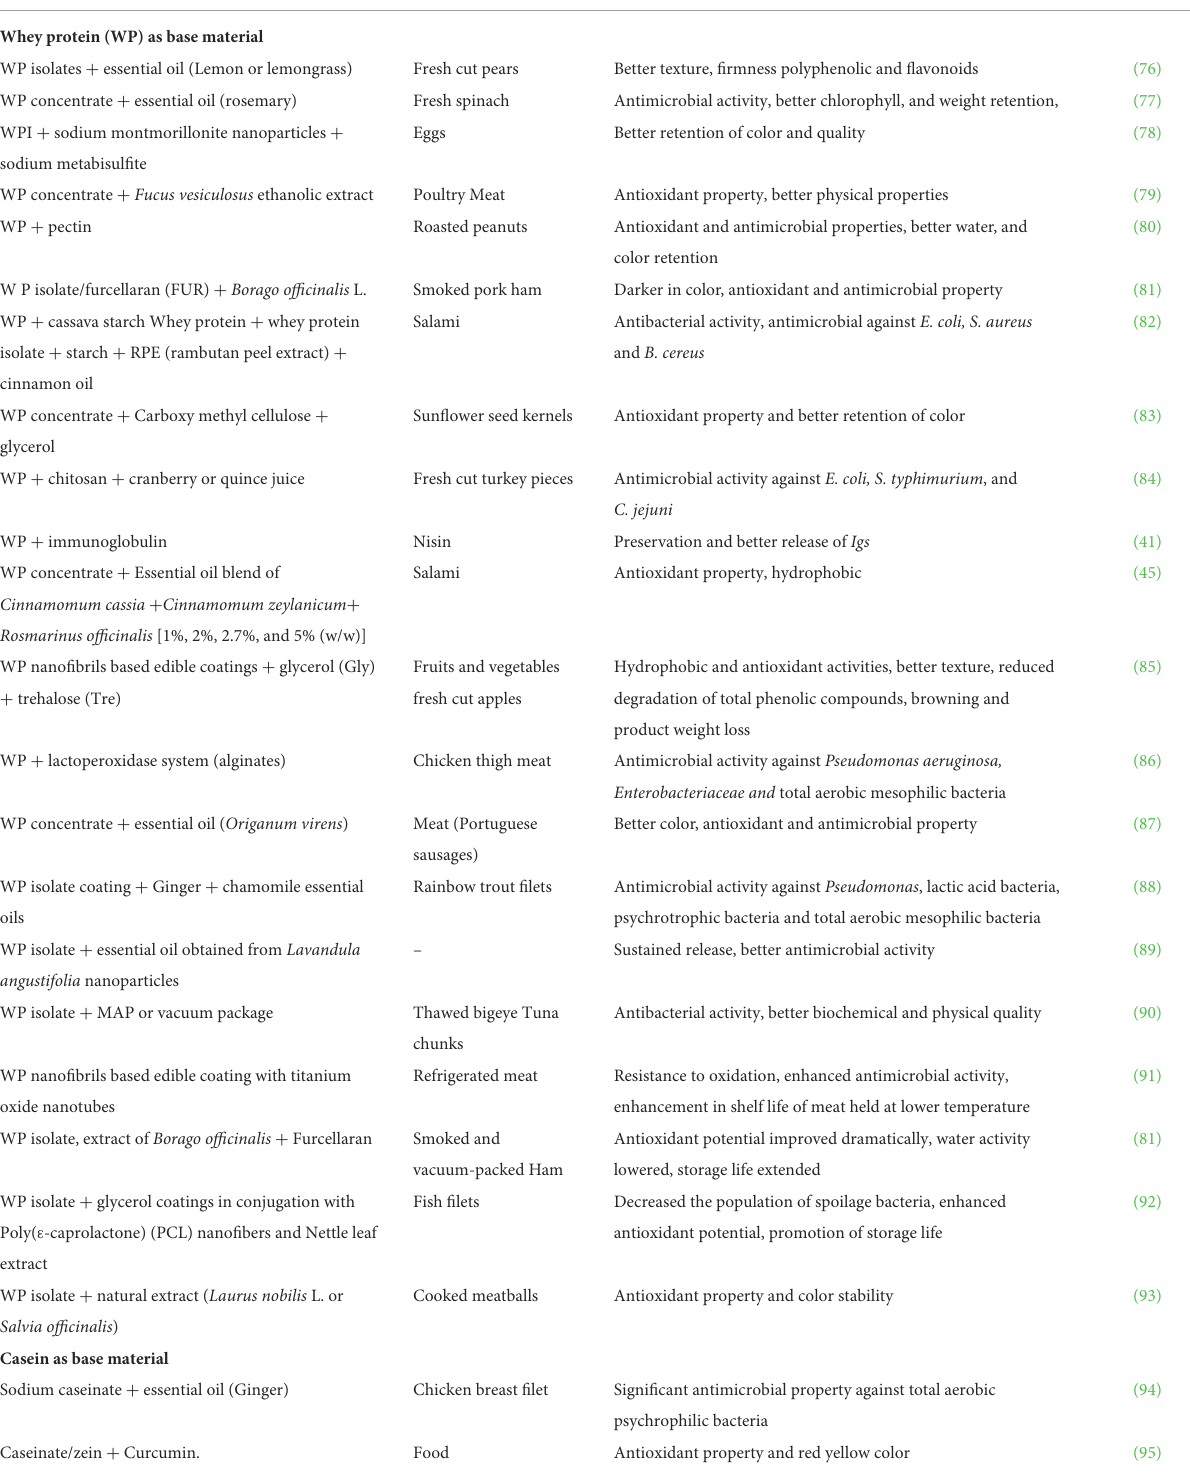
TABLE 2 Food applications of milk protein-based active edible packaging